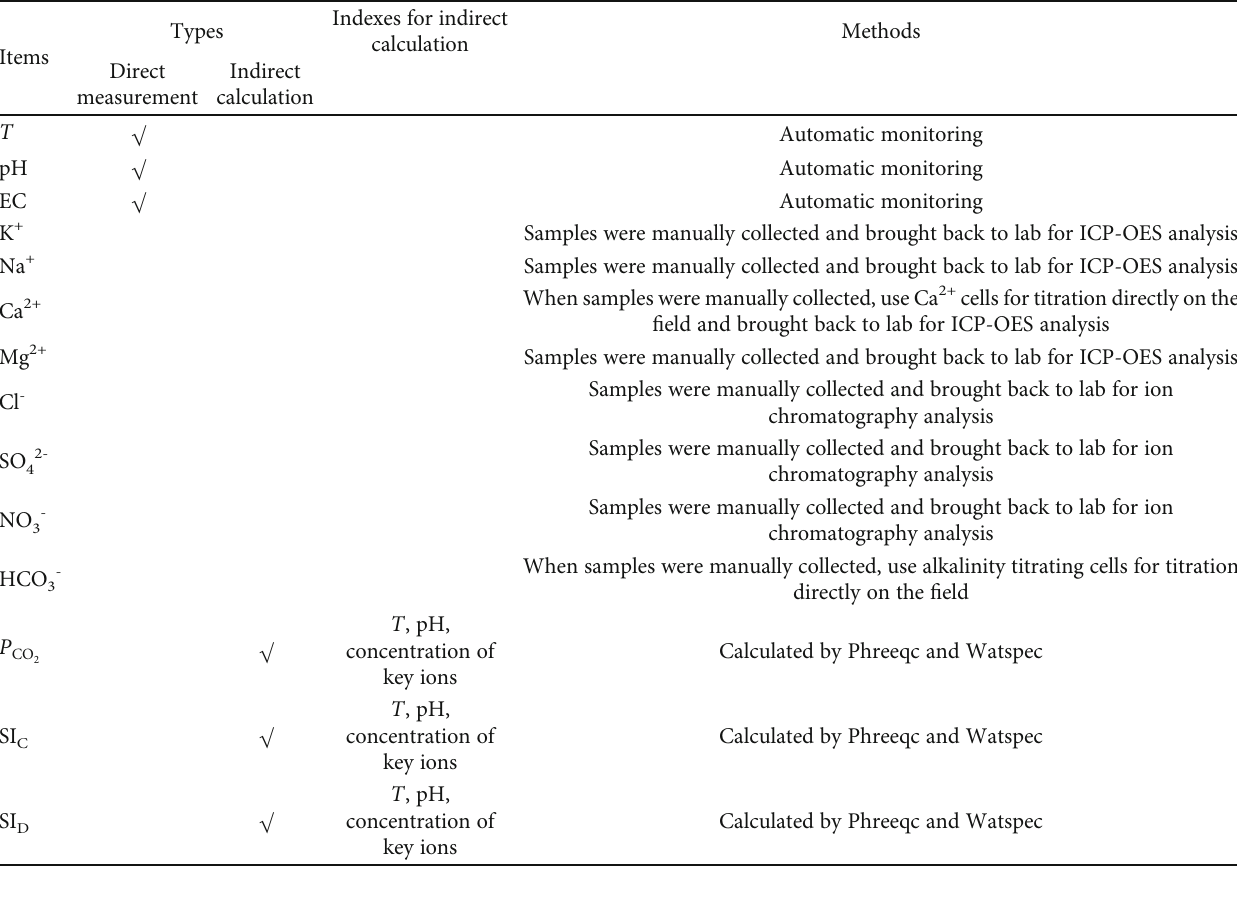
Table 2: Analyzed items and the methods used in water samples collected in the study area.